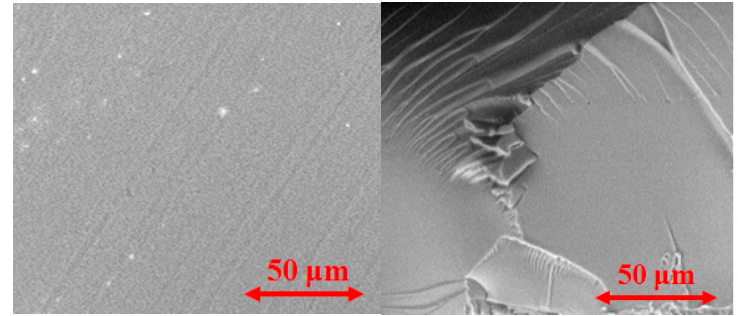
Figure 4. SEM images of dry 200 μ m poly(D,L-lactide) (PDL) 02 film: surface ( left ) and chip ( right ).